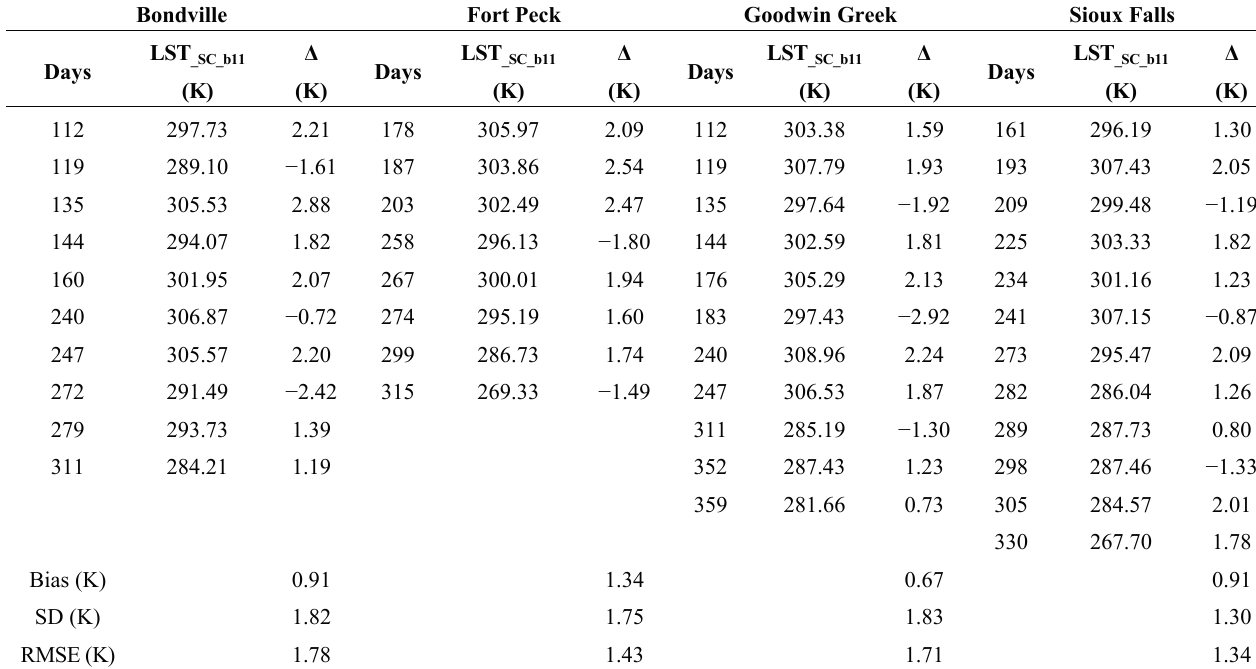
) using SC theory from TIRS band 11 and the _SC_b11 and LST for four selected _SC_b11 _g